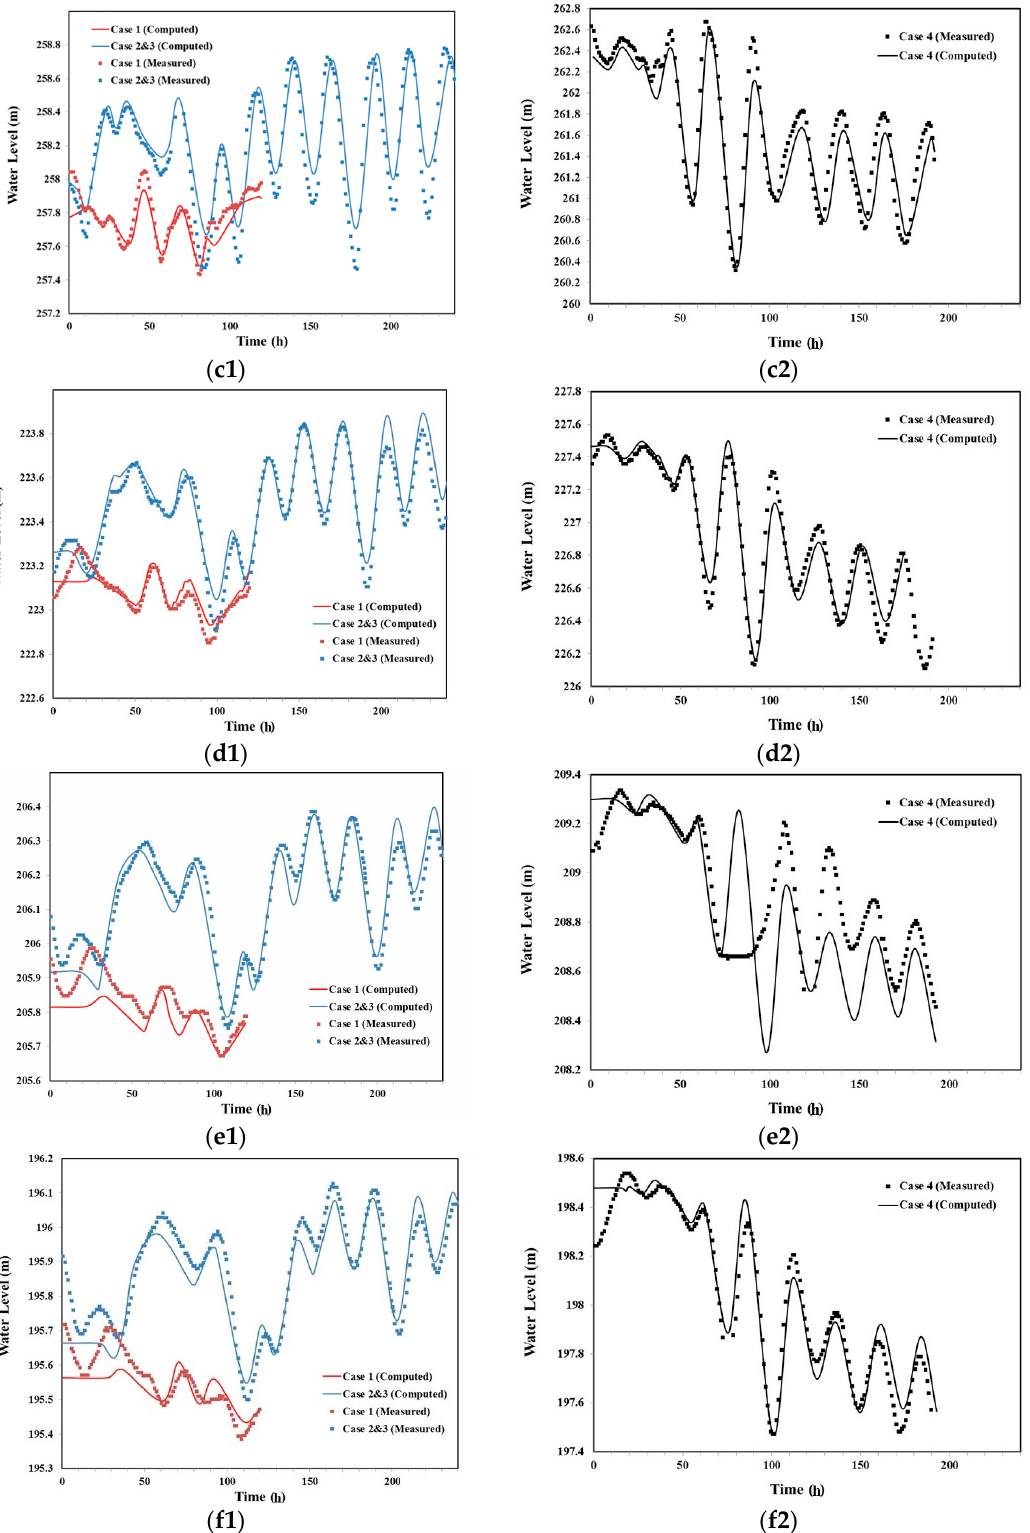
Figure 7. Computed and measured time histories of water level variations on key gauging stations: ( a ) Gaochang Hydrological Station at Min River; ( b ) Xiangjia Dam Hydropower Station at Jinsha River; ( c ) Yibin Confluence; ( d ) Luzhou City; ( e ) Hejiang; and ( f ) Zhutuo.